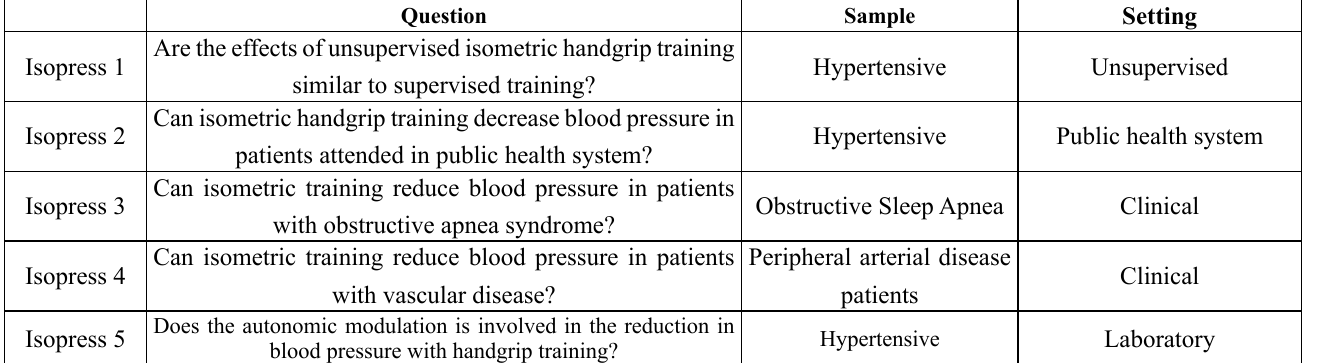
Table 1. Characteristics of studies developed in ISOPRESS